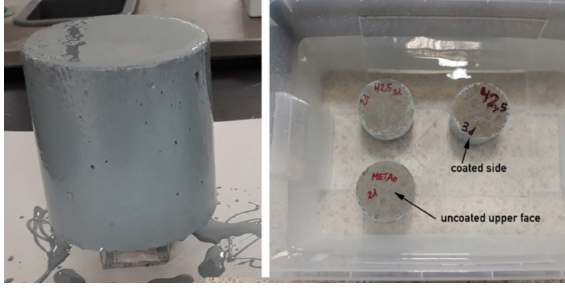
Figure 1. Sample preparation for chloride penetration tests.